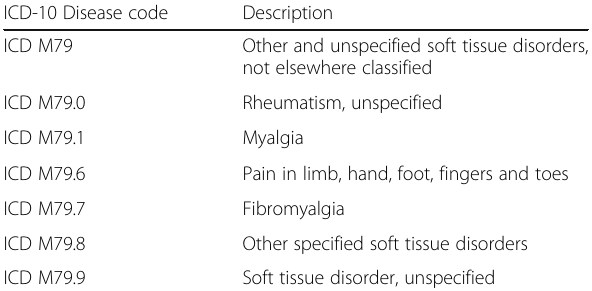
Table 1 List of ICD-10 disease codes from group M79 and its variants ICD-10 Disease code